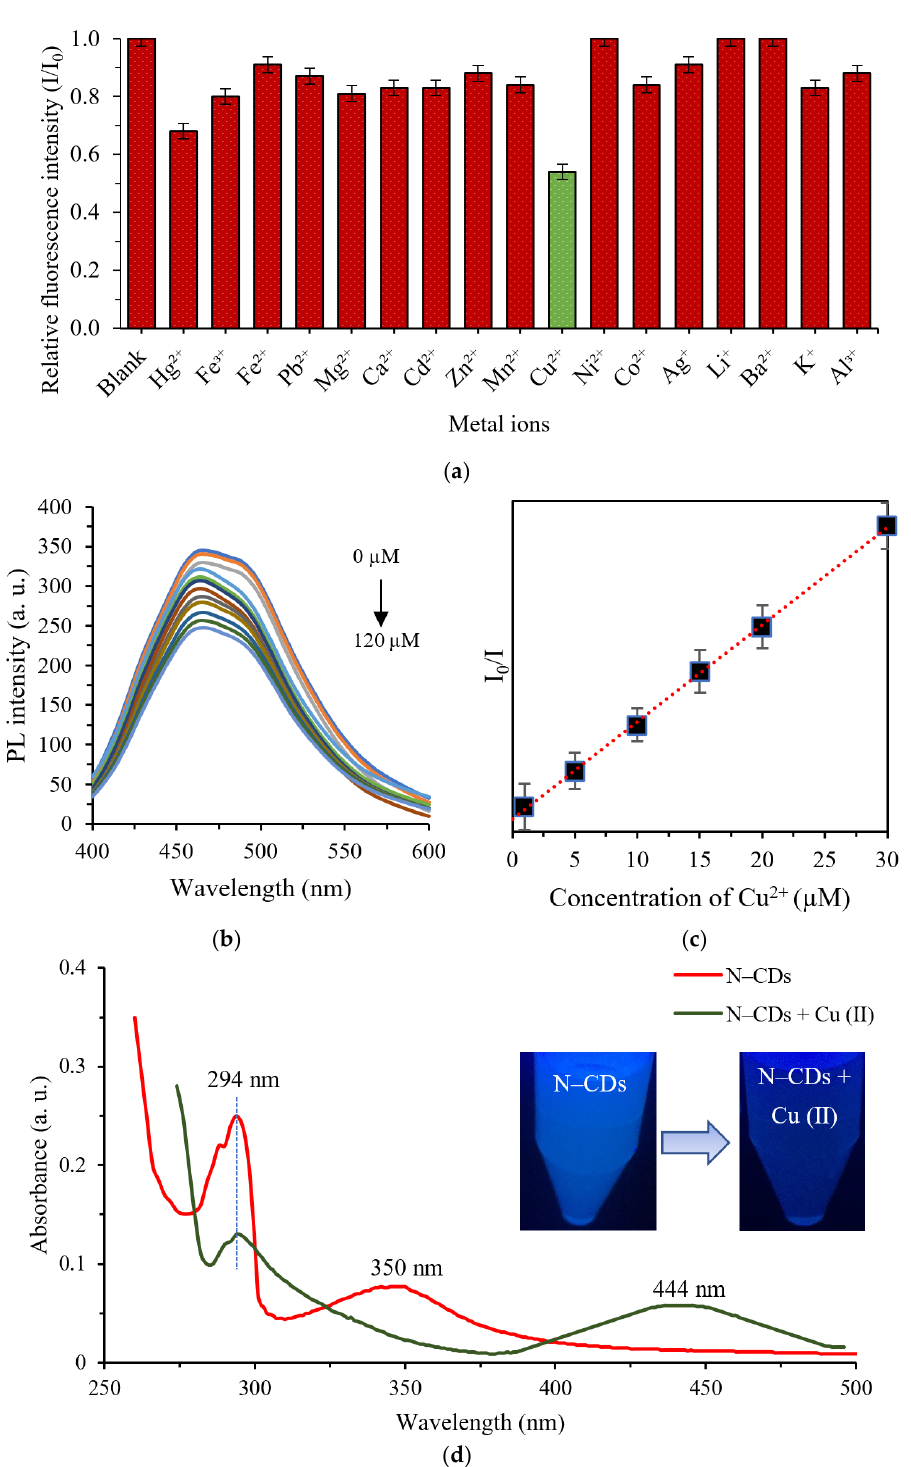
Figure 6. ( a ) Relative fluorescence intensity of aqueous N–CDs at λ em = 465.5 nm in the presence of 50 µM of various individual metal ions, ( b ) PL emission spectra of aqueous N–CDs in the presence of different concentration of Cu 2+ (0, 15, 30, 50, 70, 90 and 120 µM), ( c ) a linear correlation of I 0 /I ratio and the concentration of Cu 2+ , where I 0 and I represent the fluorescence intensity in the absence and in the presence of Cu 2+ ion, respectively and ( d ) UV-Vis absorption spectra of N–CDs before (red line) and after (black line) the addition of 700 µ M Cu (II). Inset shows the corresponding photo images of sensing under UV